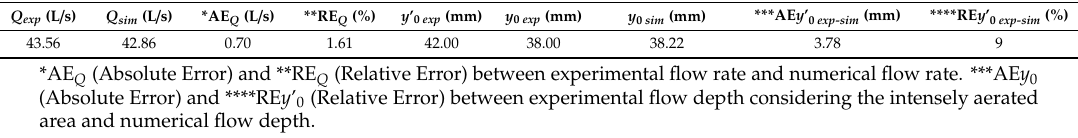
Table 5. Comparison between experimental and numerical flow rate and flow depth for validation.